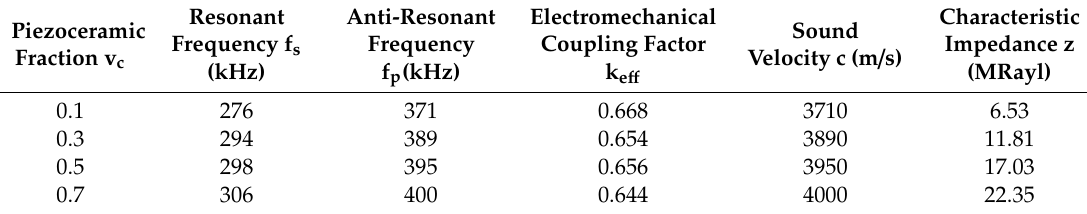
Table 6. Experiment data with di ff erent v c (v s =